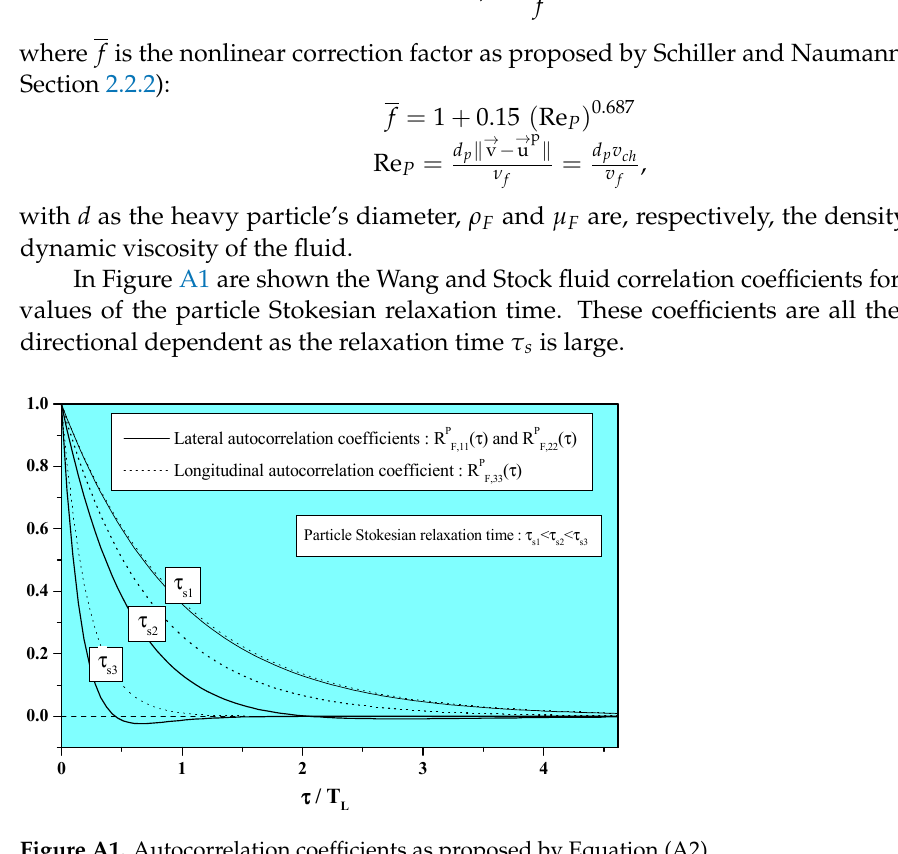
Figure A1. Autocorrelation coefficients as proposed by Equation (A2). The lateral autocorrelation coefficients (directions perpendicular to the fall direction) can have negative loops, which are more pronounced for larger drift parameters.